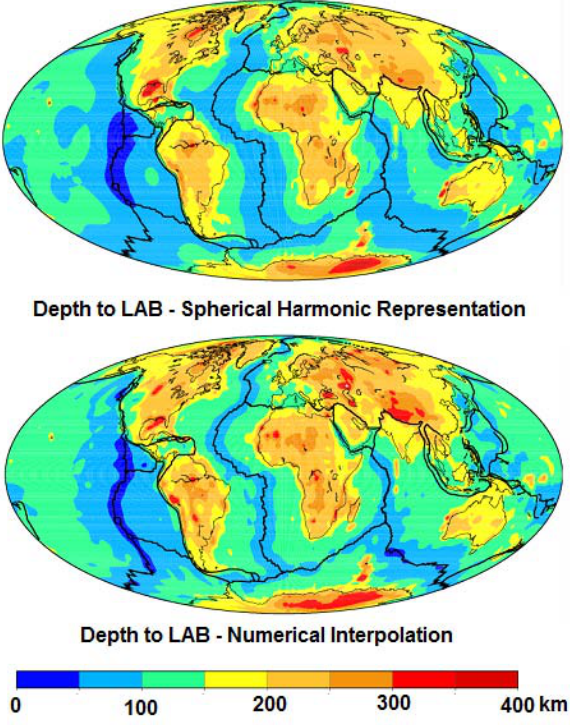
Fig. 8. Global distributions of depth to LAB in spherical harmonic representation (upper panel) and numerical interpolation methods (lower panel). Note that almost all of the continental areas are char- acterized by lithospheric thickness greater than